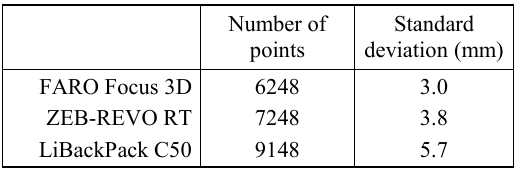
Table 2. Analysis of measurement noise for the reference cloud and the two MMS clouds